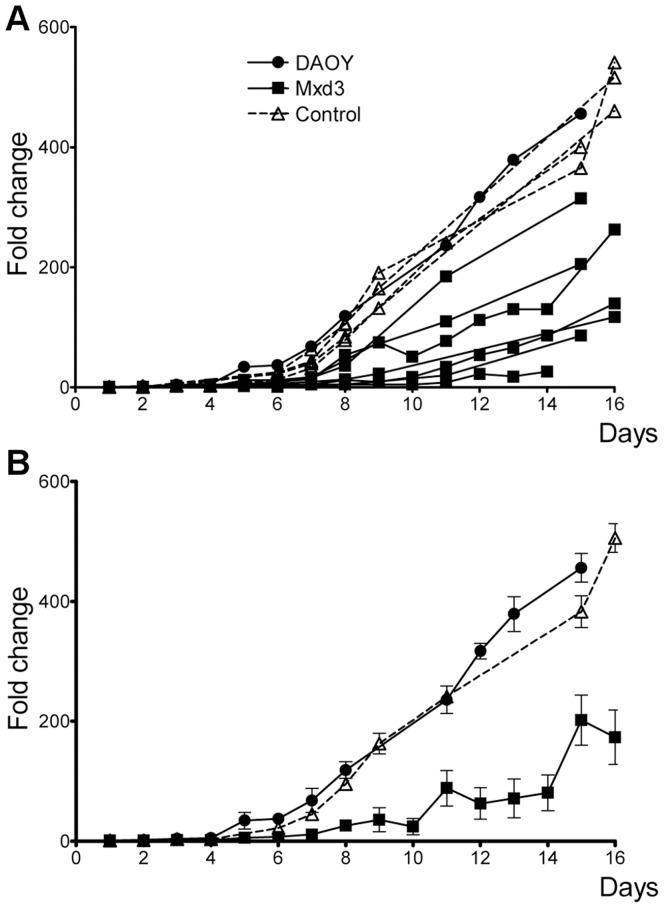
Persistent expression of MXD3 reduces cell proliferation.(A) Proliferation curves for DAOY (filled circles), individual “M” (filled squares) and “C” (open triangles) cell lines expressed as fold increase from starting cell count. Each data point represents the mean ± SD of 2–3 independent experiments. All cell lines overexpressing MXD3 showed reduced cell proliferation. Control lines were not different from the parental line. For clarity, the same traces are used for different cell lines within each group. (B) For statistical analysis, proliferation data from all cell lines in (A) were pooled into 3 groups: DAOY (filled circles), MXD3 (filled squares) and control (open triangles). From day eight onwards, MXD3 group showed significantly slower proliferation than the parental or control groups (p<0.01, n  = 15, two-way ANOVA with Scheffe post-test for individual comparisons between groups).